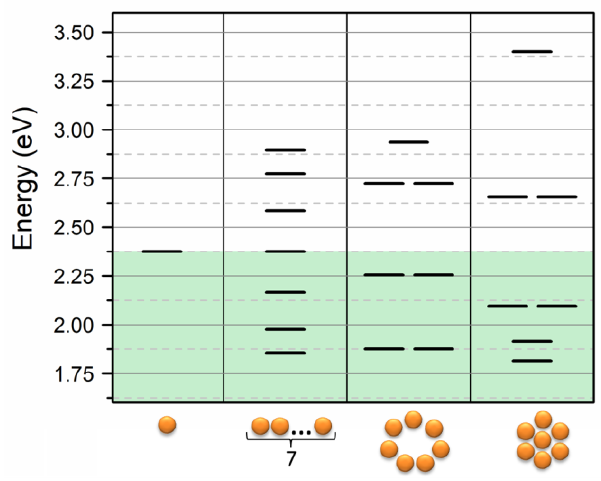
Figure 5. Energy diagram of the linear combination obtained in the case of heptamer geometries: linear, ring, and cluster. Input data are ω 0 = 2.375 eV and β = − 0.28 eV.